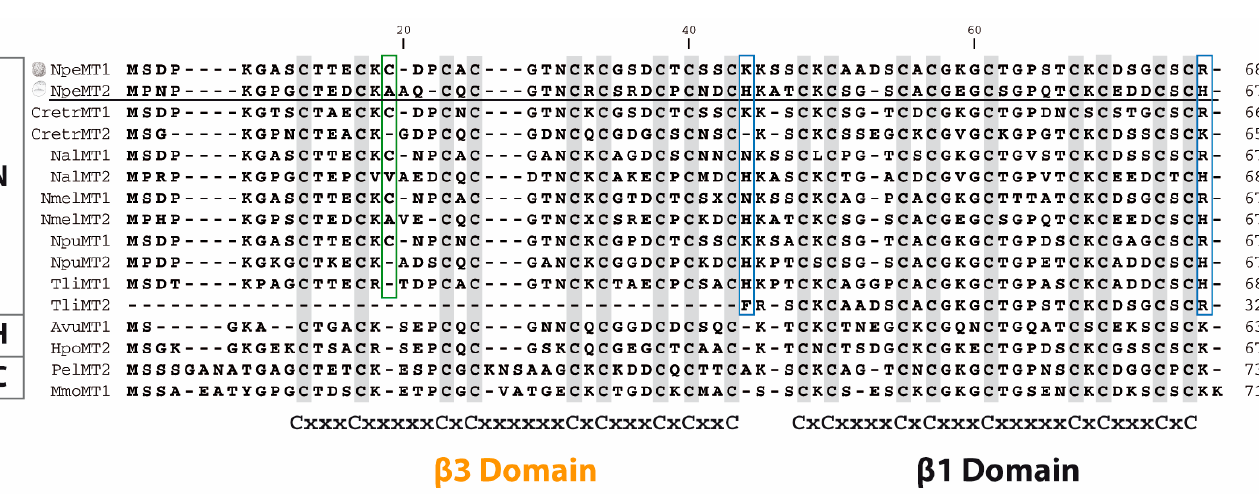
Figure 1. Amino acid alignment of Neritimorpha (N) MTs including those of Nerita peloronta (NpeMT1 and NpeMT2), Clithon retropictum (CretrMT1 and CretrMT2), Nerita albicilla (NalMT1 and NalMT2), Nerita melanotragus (NmelMT1 and NmelMT2), Neritina pulligera (NpuMT1 and NpuMT2), and Titiscania limacina (TliMT1 and TliMT2). Neritimorpha MTs are compared and aligned with selected MTs of Heterobranchia (H) and Caenogastropoda (C): Arion vulgaris (AvuMT1), Helix pomatia (HpoMT2), Pomatias elegans (PelMT2), and Marseniopsis mollis (MmoMT1). Conserved cysteines are highlighted with a grey background. Extra cysteines in the MT1 of the Neritimorpha are highlighted in a green box and extra histidines in the MT2s are in a blue box. Cysteine arrangements in the respective β 3 and β 1 domains are shown below the alignment.